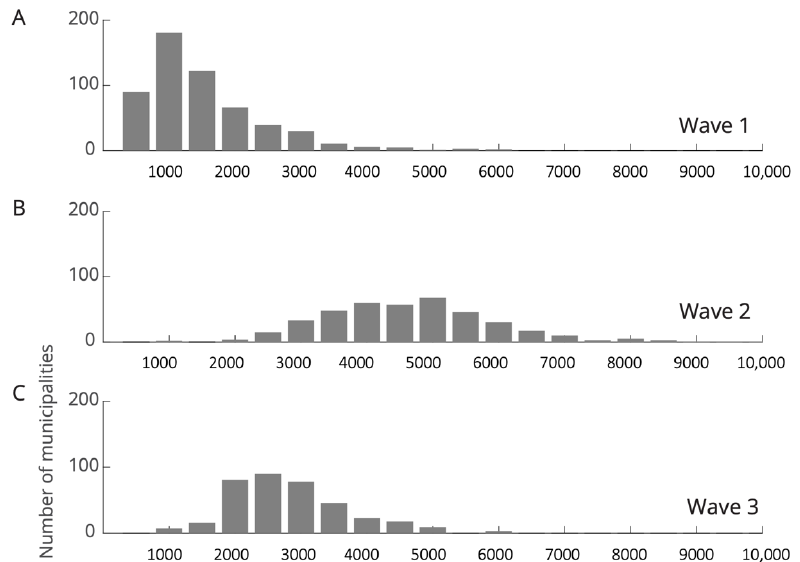
Figure A1. Frequency histogram of COVID-19 infections per 100,000 population in New Jersey mu- nicipalities during Wave 1 (sub-figure A, n = 558 municipalities), Wave 2 (sub-figure B, n = 406 mu- nicipalities), and Wave 3 (sub-figure C, n = 271 municipalities). Bins are in increments of 500 cases per 100,000 population. The number displayed indicates the higher bin edge, so that 1000 indicates values between 500 and 1000. The height of the bar shows the number of New Jersey municipalities with rates falling in that bin. A few extreme values (2 in the top panel and 2 in the middle panel) fall out of the range of the plot.